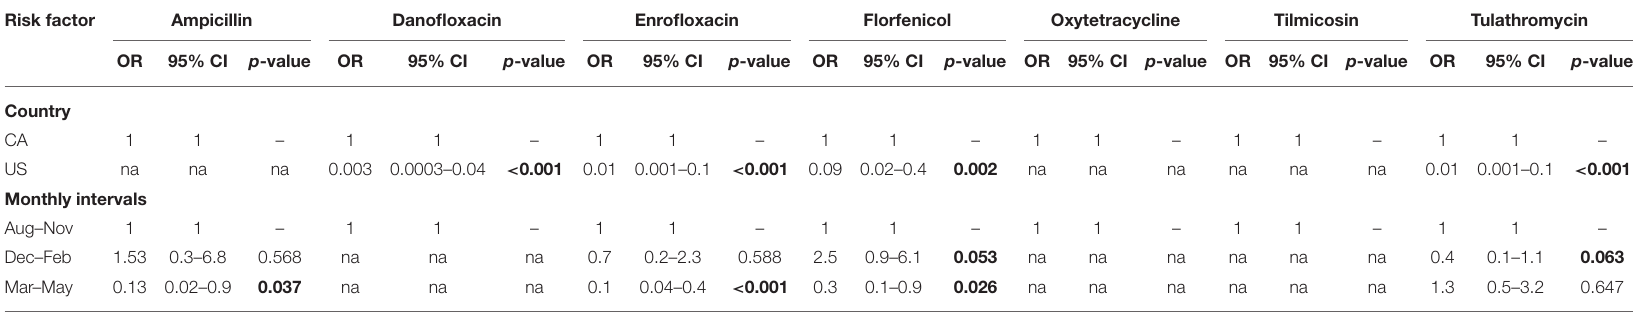
TABLE 8 | Significant results obtained from logistic regression of antimicrobial resistant Pasteurella multocida from dairy-type cattle upon feedlot arrival. Risk